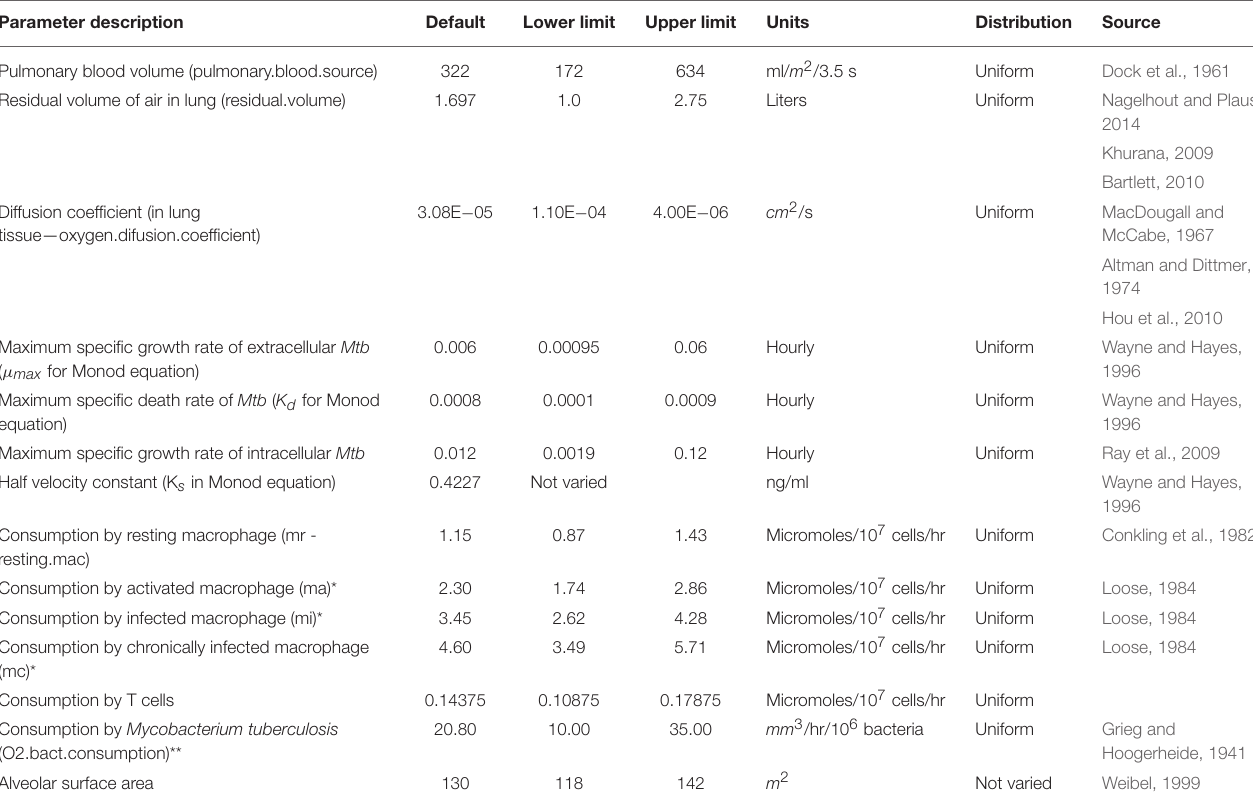
TABLE 1 | Oxygen parameters used in the integrated multiscale